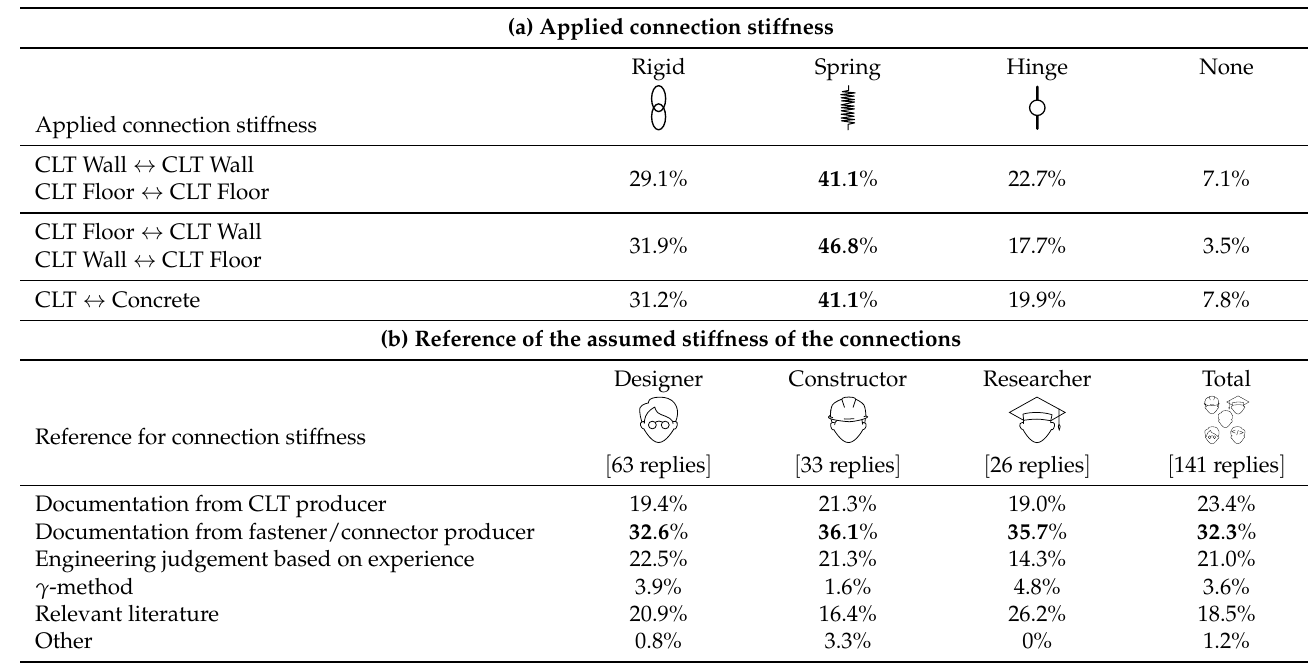
Table 6. Questions related to design of connections (single choice).